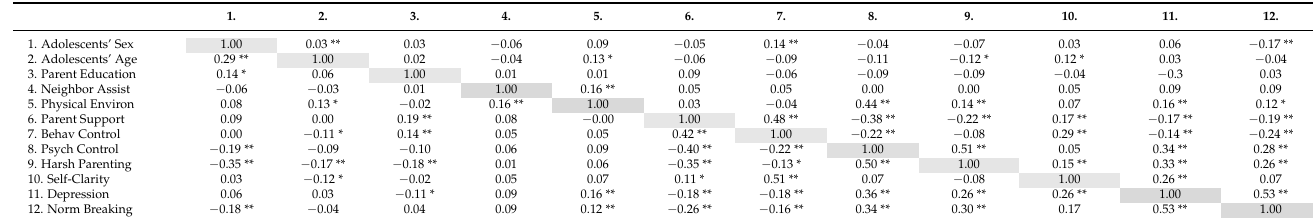
Table 1. Correlations among study variables.